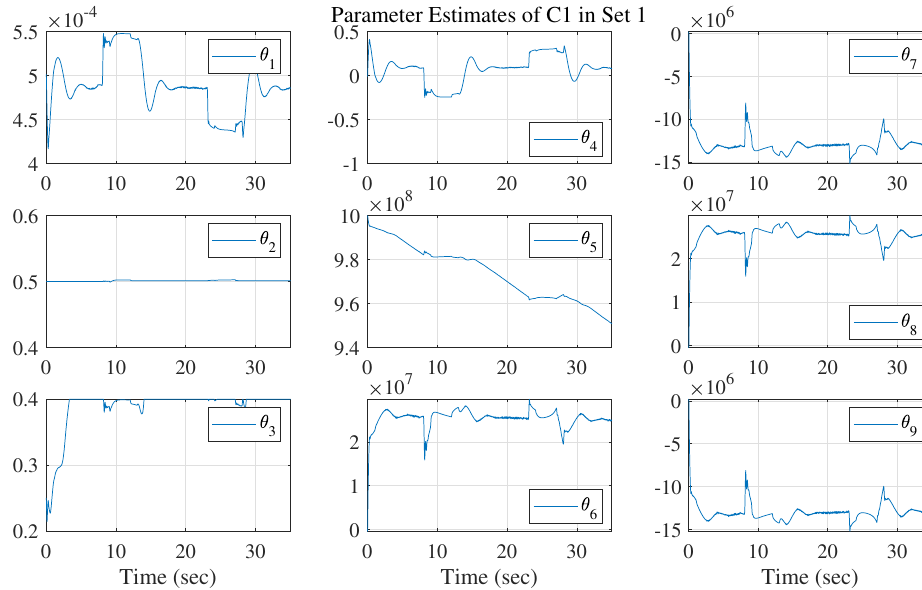
Figure 9. Parameter estimation results of C1 in Set 1.